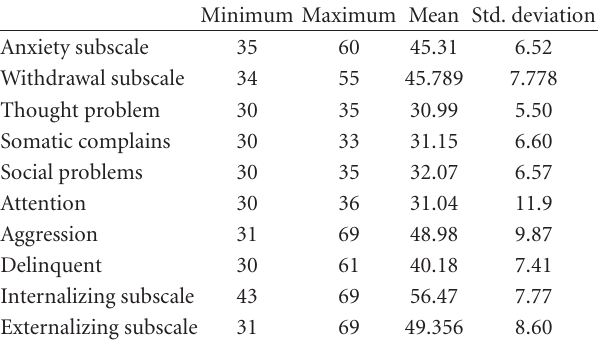
Table 4: Psychiatric diagnoses of the orphans according to DSM